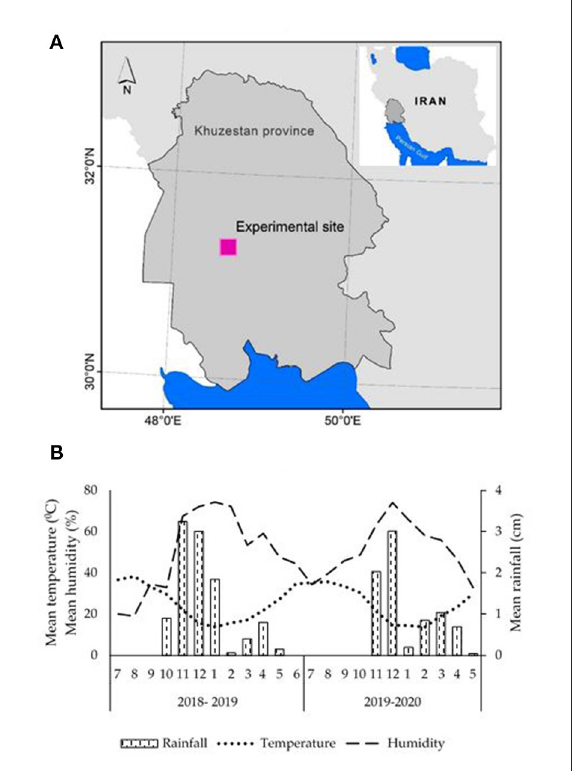
FIGURE1 (A) Location of the experimental site in Iran, (B) Monthly average of rainfall, mean temperature, and humidity at the experimental site during